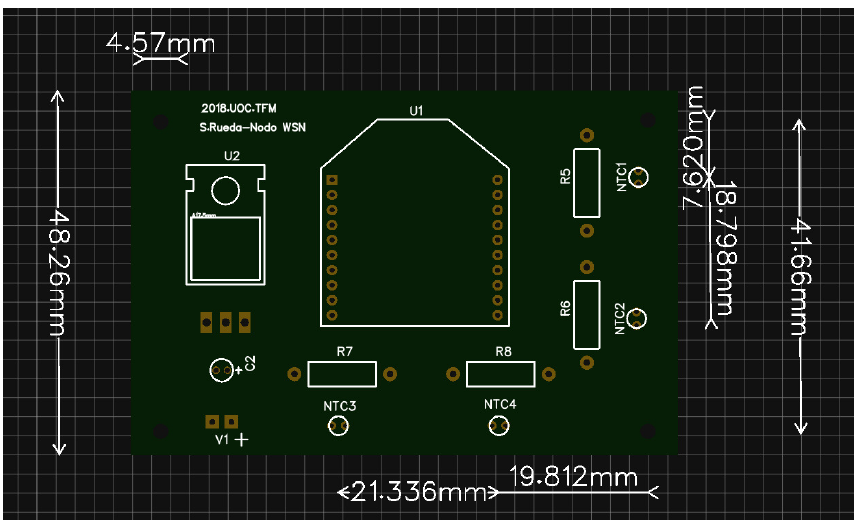
Figure 4. Printed circuit board (PCB) front view from the sensor node using the EasyEDA.